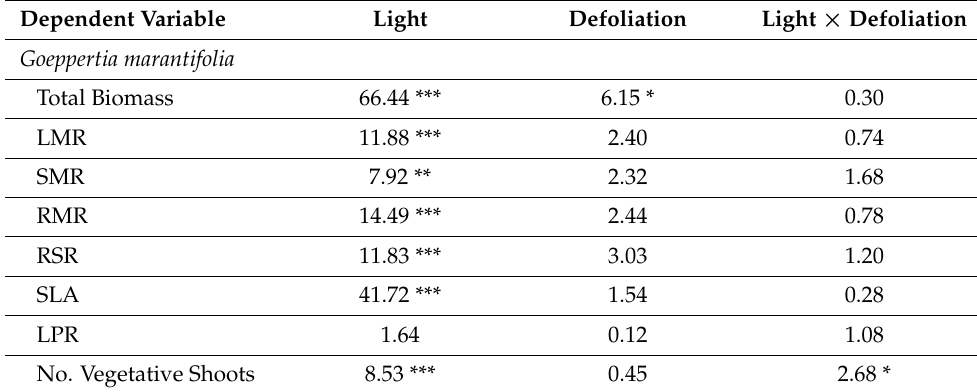
Table 1. Results from the split-plot two-way ANOVA using defoliation (control, 50% and 100% leaf removal) and light availability (low, intermediate and high) as fixed factors affecting metrics of growth for four broad-leaved understory species. Data were collected at the end f the experiment for total biomass, leaf mass ratio (LMR), stem mass ratio (SMR), root mass ratio (RMR), root to shoot ratio (RSR), specific leaf area (SLA), leaf production rate (LPR), and number of vegetative shoots. Analyses were conducted separately for each species. Asterisks show levels of significance in p values; * p < 0.05, ** p < 0.01, *** p <